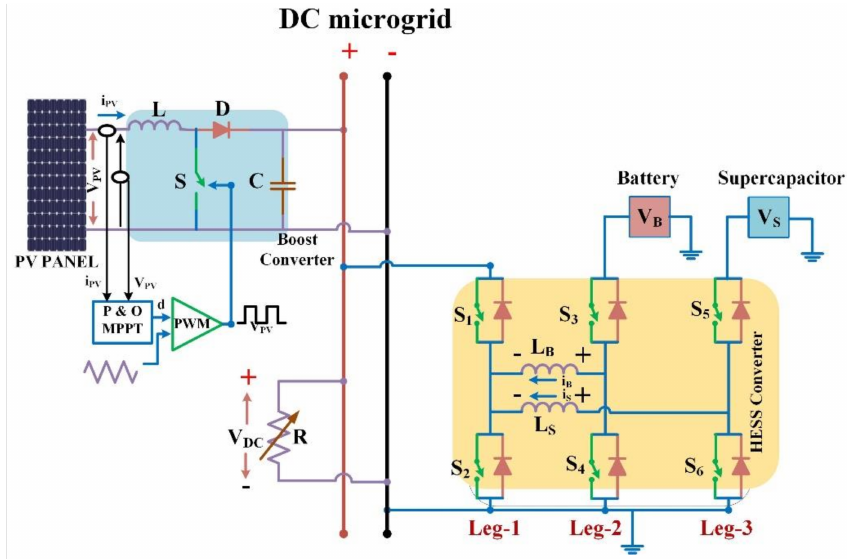
Figure 2. HESS and PV system in a DC microgrid design.